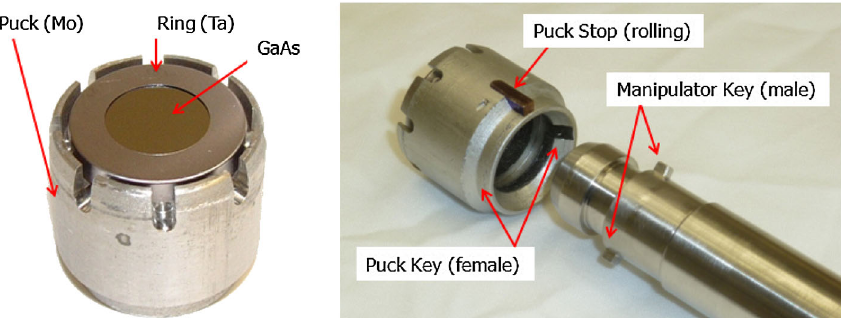
FIG. 5. (Left) Photocathode attached to a puck and (right) the tip of the long manipulator being inserted into the rear of the puck